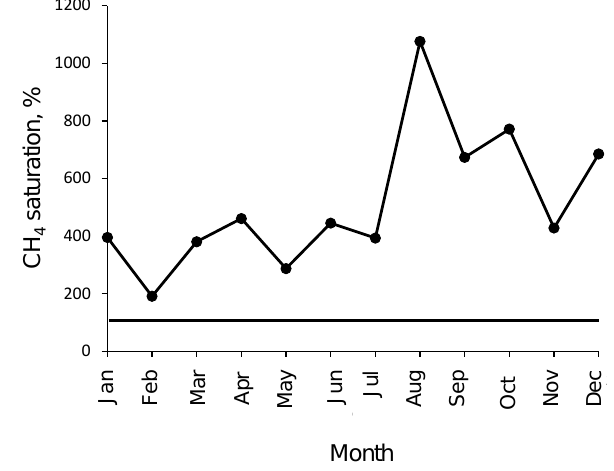
Fig. 4. Monthly mean CH 4 surface saturations at Boknis Eck. The vertical bold line indicates equilibrium with the atmosphere (i.e. 100%